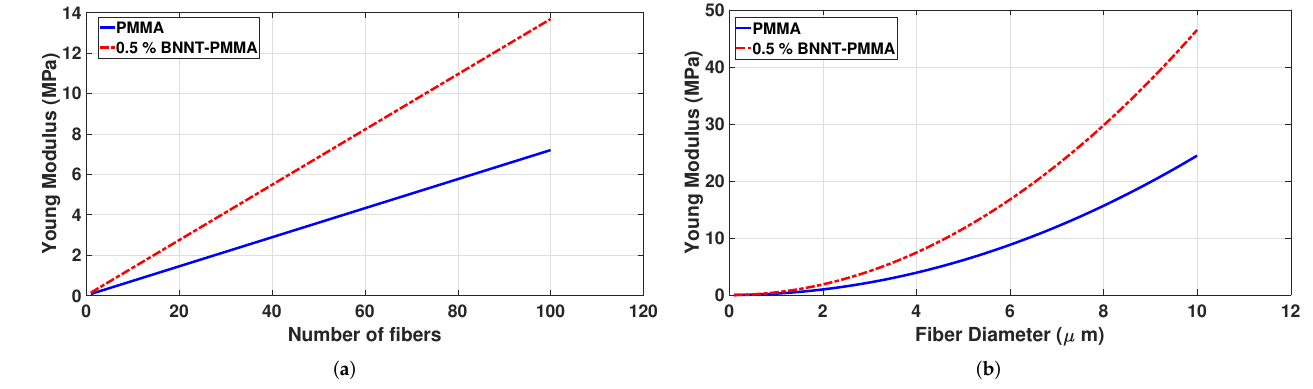
Figure 7. The variation of the Young’s modulus of the PMMA and BNNT-PMMA nanocomposite mesh with: ( a ) number of the single fibers; ( b ) diameter of the single